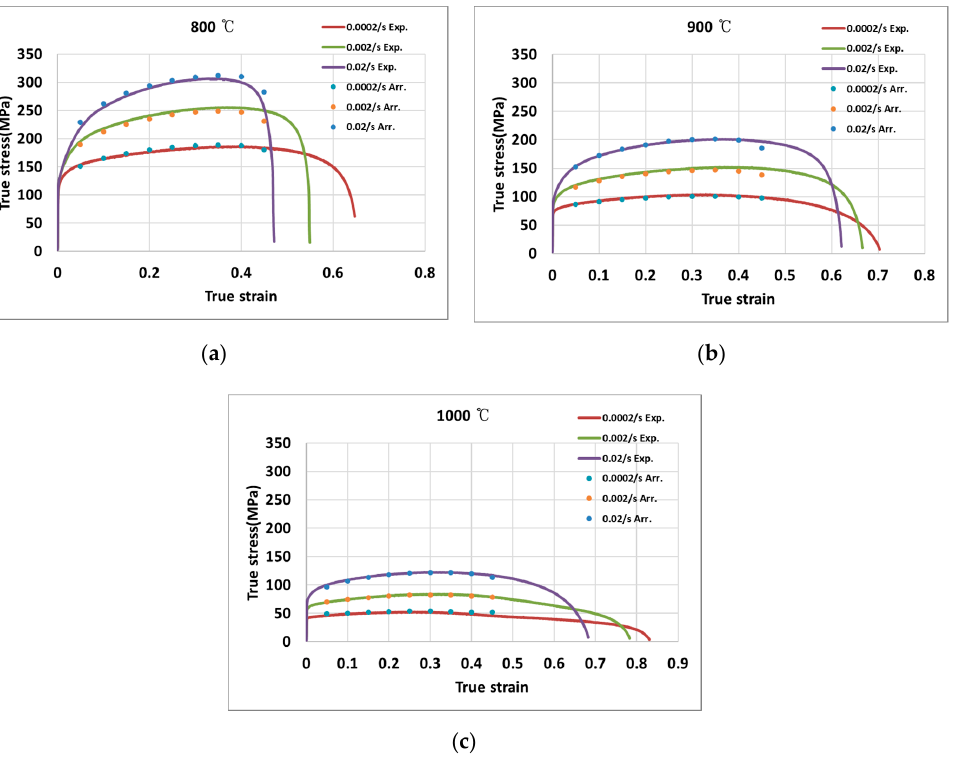
Figure 8. True stress-true strain curves at ( a ) 800 °C; ( b ) 900 °C; ( c ) 1000 °C.